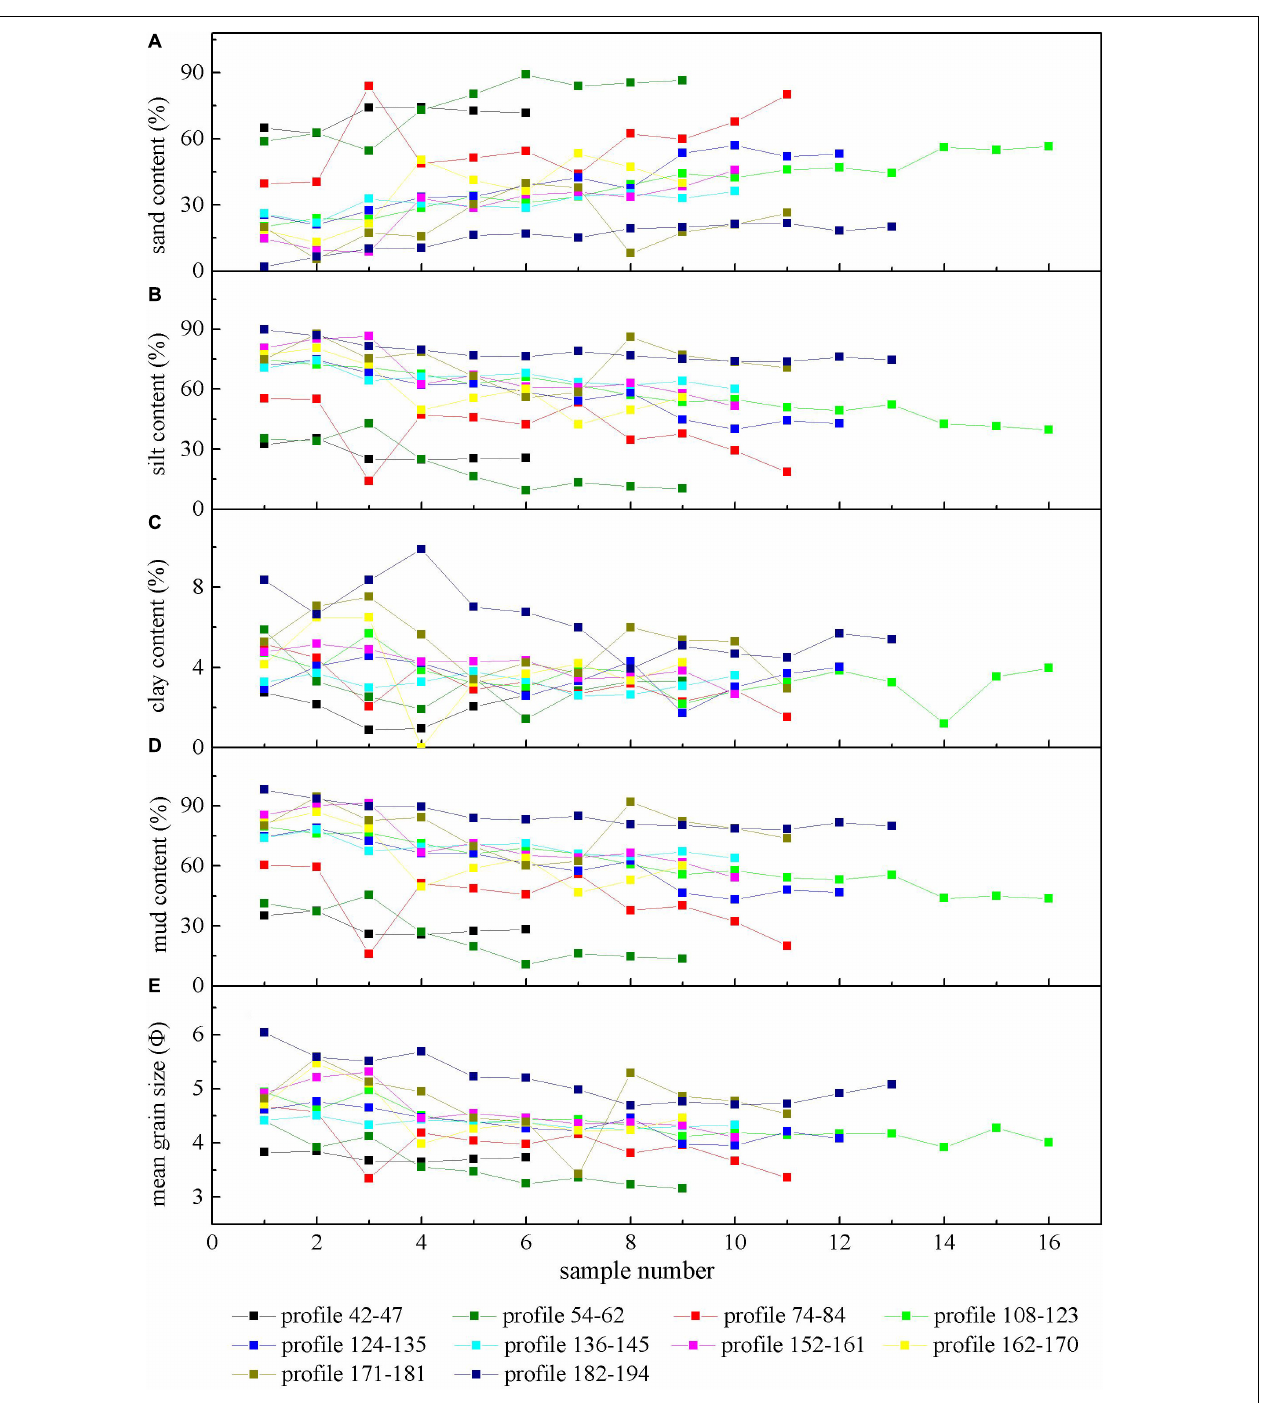
FIGURE 3 | The profile change curves of sand content (A) , silt content (B) , clay content (C) , mud content (D) and mean grain size (E) of tidal flat surficial sediments from the ASYS and adjacent zones.